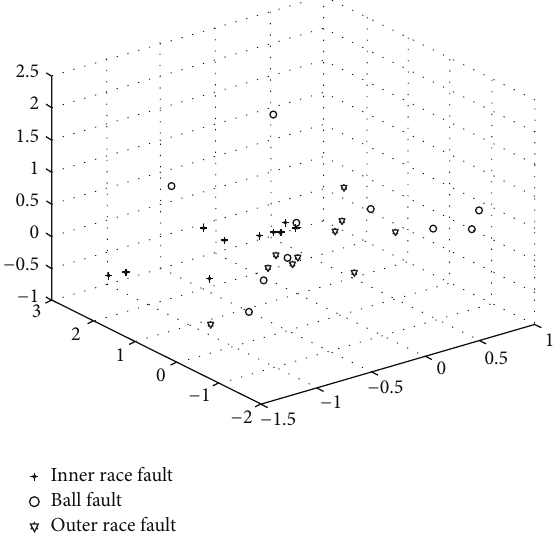
Figure6:Theresultofthesignalnotpurifiedbyoptimizedmorpho- logical filter and use of the LTSA to extract the original features.